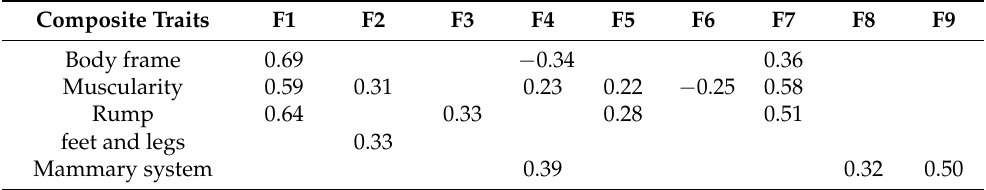
Table 7. Pearson correlation coefficients (only values ≥ | 0.20 | ) between EBVs estimated for body conformation traits and EBVs obtained from 9 factor scores (from F1 to F9) in dual-purpose Simmental